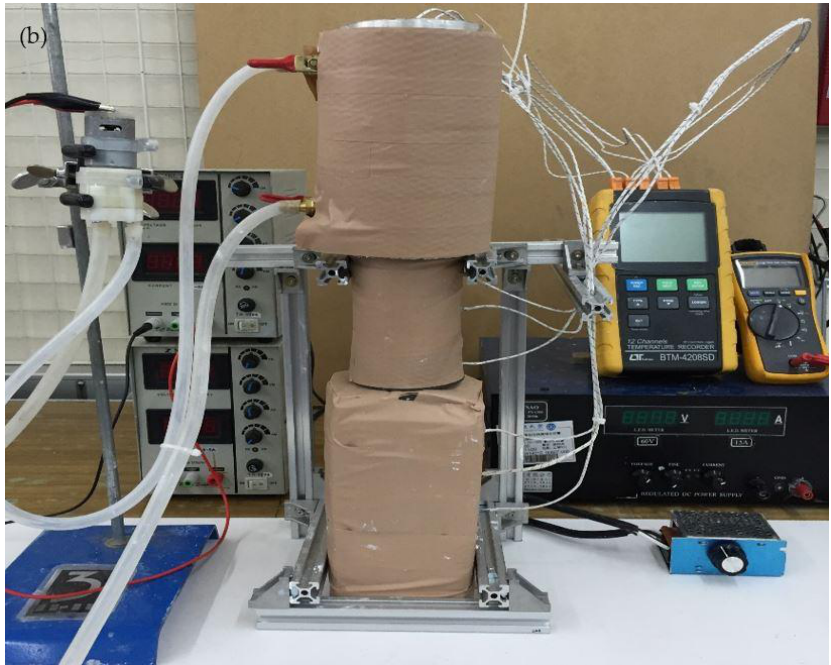
Figure 5. Thermal performance test system: ( a ) Schematic drawing; and ( b ) photograph.